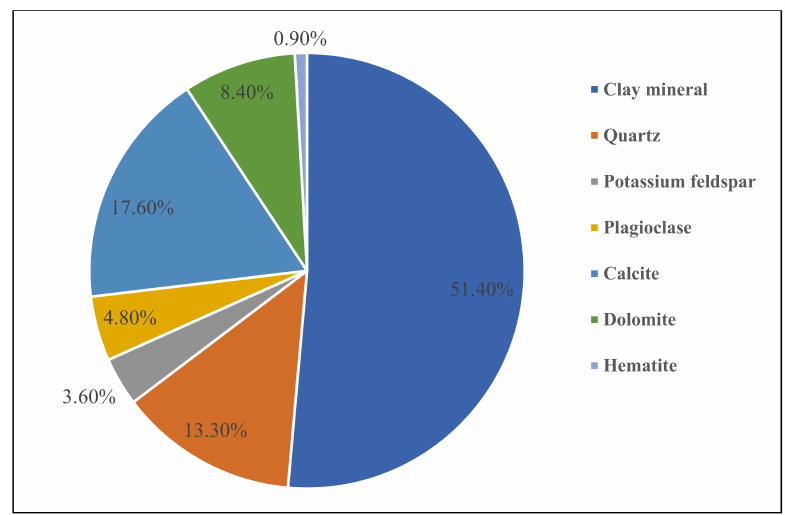
Figure 5. Proportion of different mineral types as determined by XRD for PM 10 collected during the dust